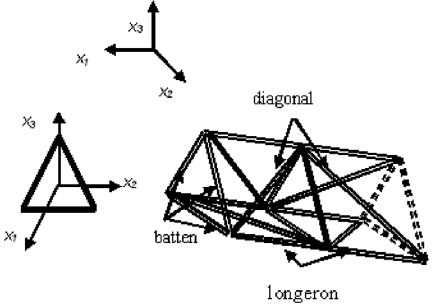
Fig. 2. Fundamental element of the ISAT